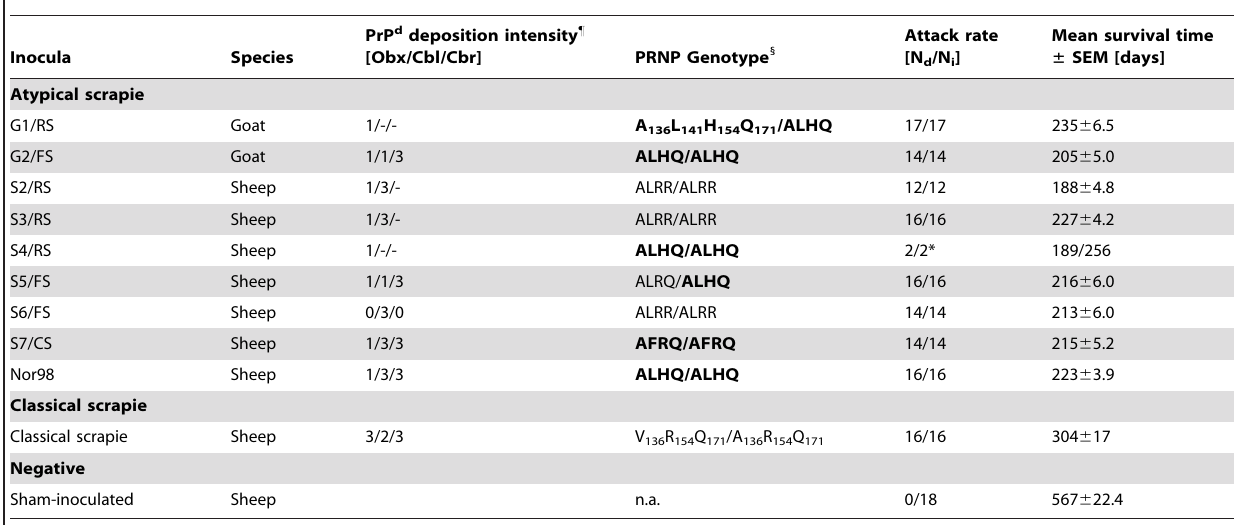
Table 1. Small ruminant isolates, attack rates, and survival times in tg338 mice. #